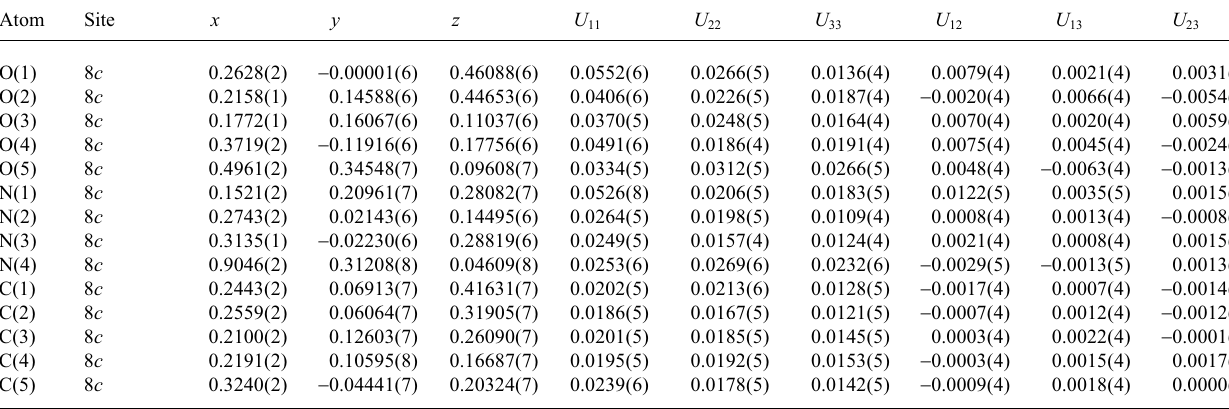
Table 3. Atomic coordinates and displacement parameters (in Å 2 )